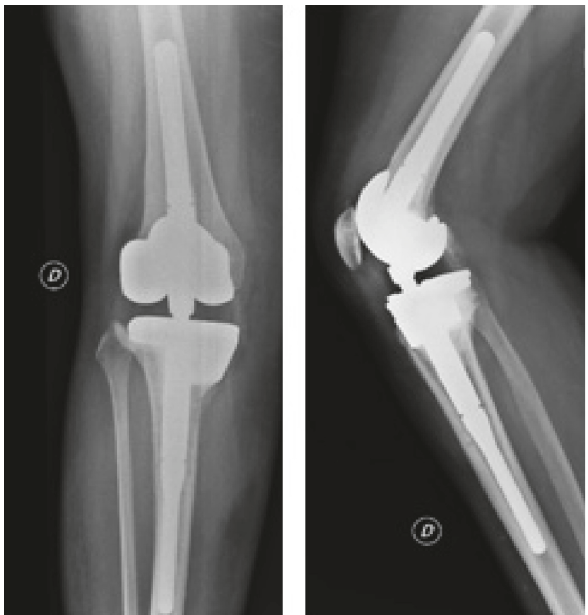
Figure 11: X-rays showing 3 months postoperatively rotating hinge total knee replacement with metal augment.